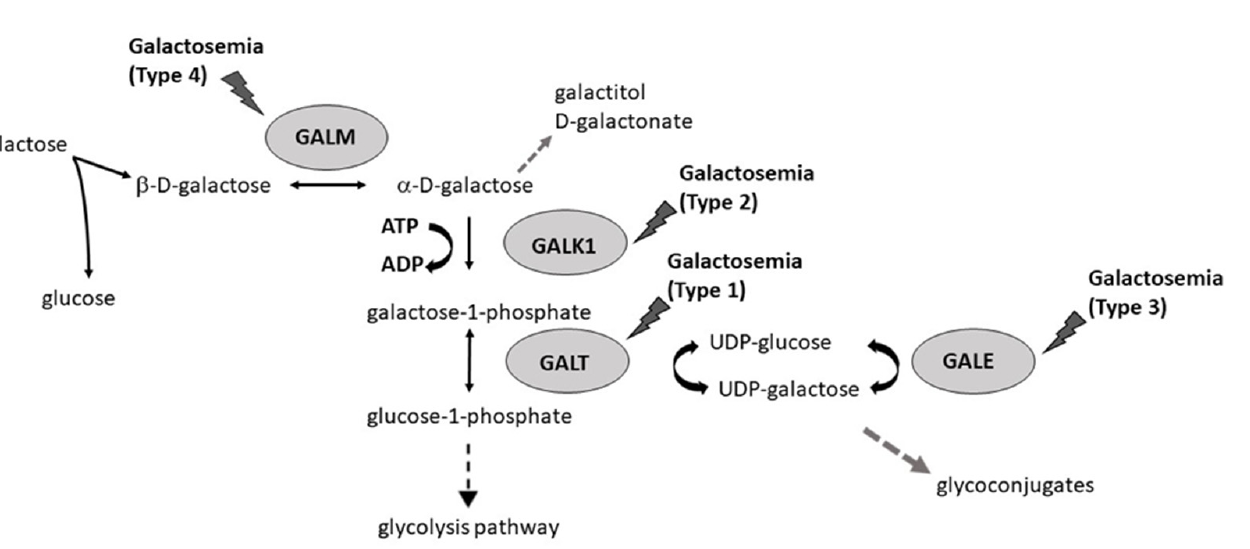
Figure 1. Schematic representation of the Leloir pathway and associated reactions. Several forms of galactosemia can be caused by deficiency of GALM, GALT, GALK1, or GALE.